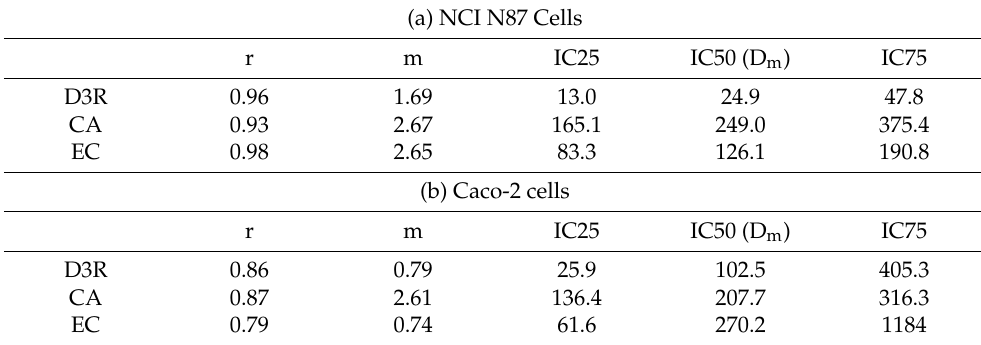
Figure 1. Viability (%) of proliferating NCI-N87 and Caco-2 cells exposed to dilutions of EC, CA, and D3R (µM) for 72 h, ( a ) isolated and ( b ) in binary combination (CA+EC, CA+D3R, and EC+D3R). Data are presented as mean ± SD of at least two independent experiments. Table 1. Dose-effect parameters for individual exposure of polyphenols on NCI-N87 and Caco-2 cells.